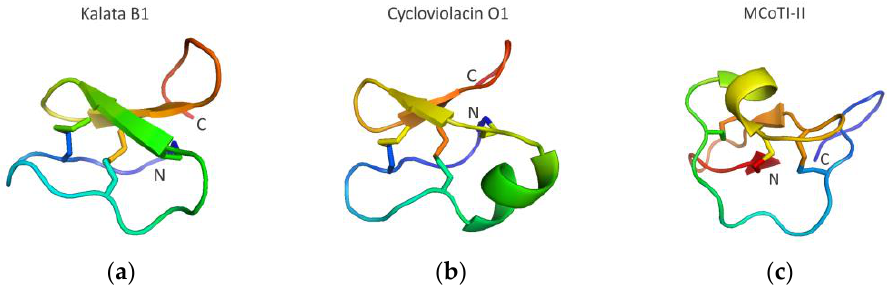
Figure 5. Structure of the main cyclotide subfamilies. ( a ) Structure of the Möbius, kalata B1, cyclotide PDB ID 1NB1); ( b ) structure of the bracelet, cycloviolacin O1 cyclotide, PDB ID 1NBJ; ( c ) structure of the trypsin inhibitor, MCoTI-II cyclotide, PDB ID 1IB9. Disulfide bridges are shown as sticks.